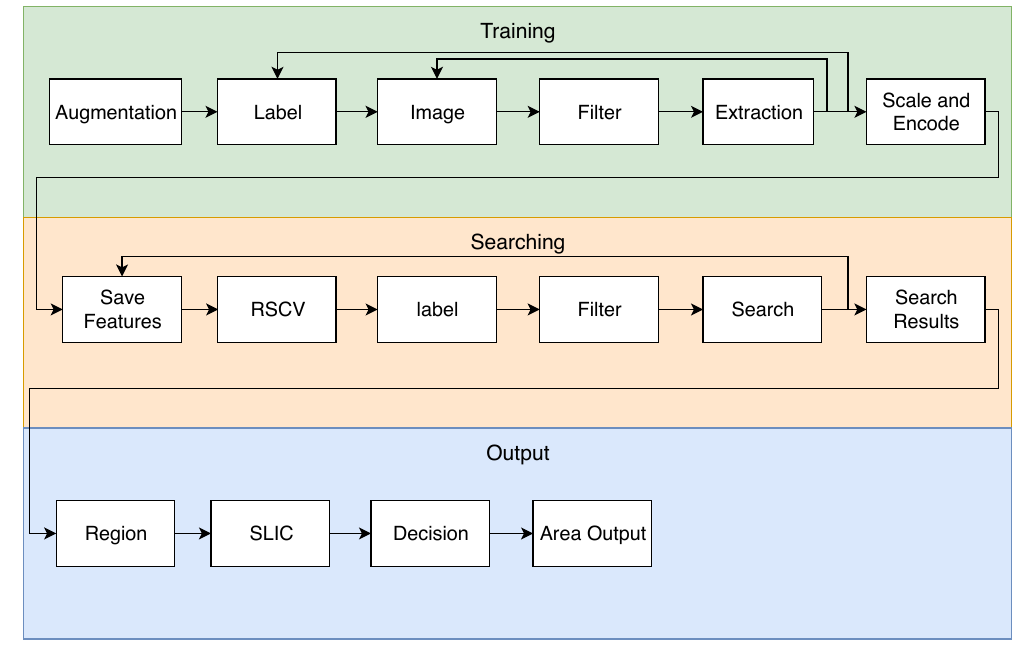
Figure 4. Flowchart describing the bush monitoring routine. RSCV, Randomized Search